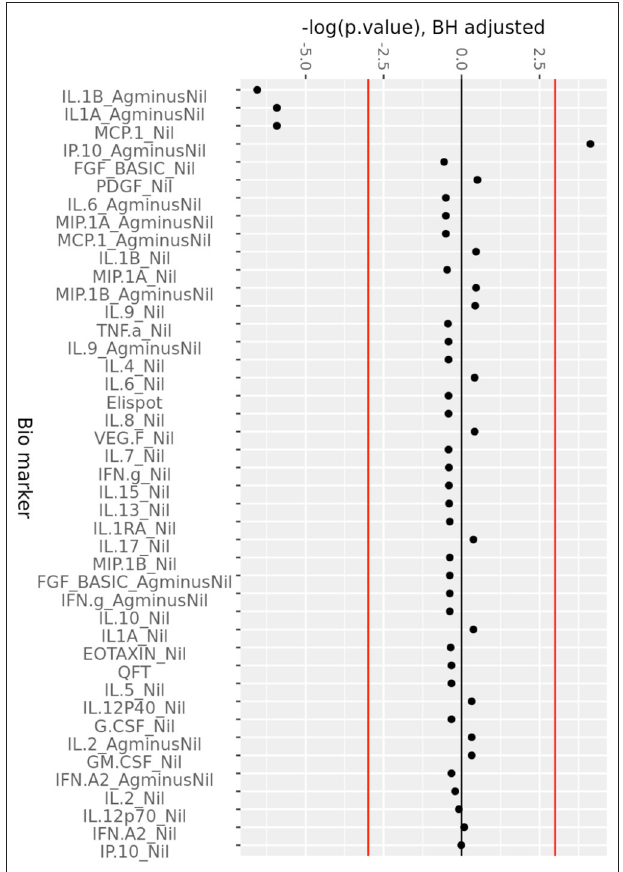
FIGURE 2 | Consistent change in QFT plasma analytes over 6 months of ART. Minus log-transformed p -values for each analyte, resulting from the Limma analysis framework, after BH FDR correction, considering all timepoints. Sign represents direction of effect size (negative: decrease from D0 level, positive: increase from D0 level). Red lines: α significance thresholds.